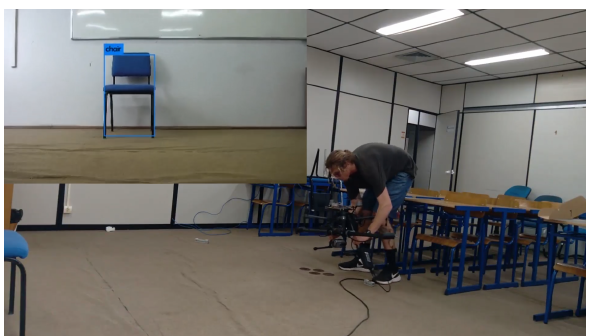
Figure 12. Practical experiment using YOLOv3 dataset.